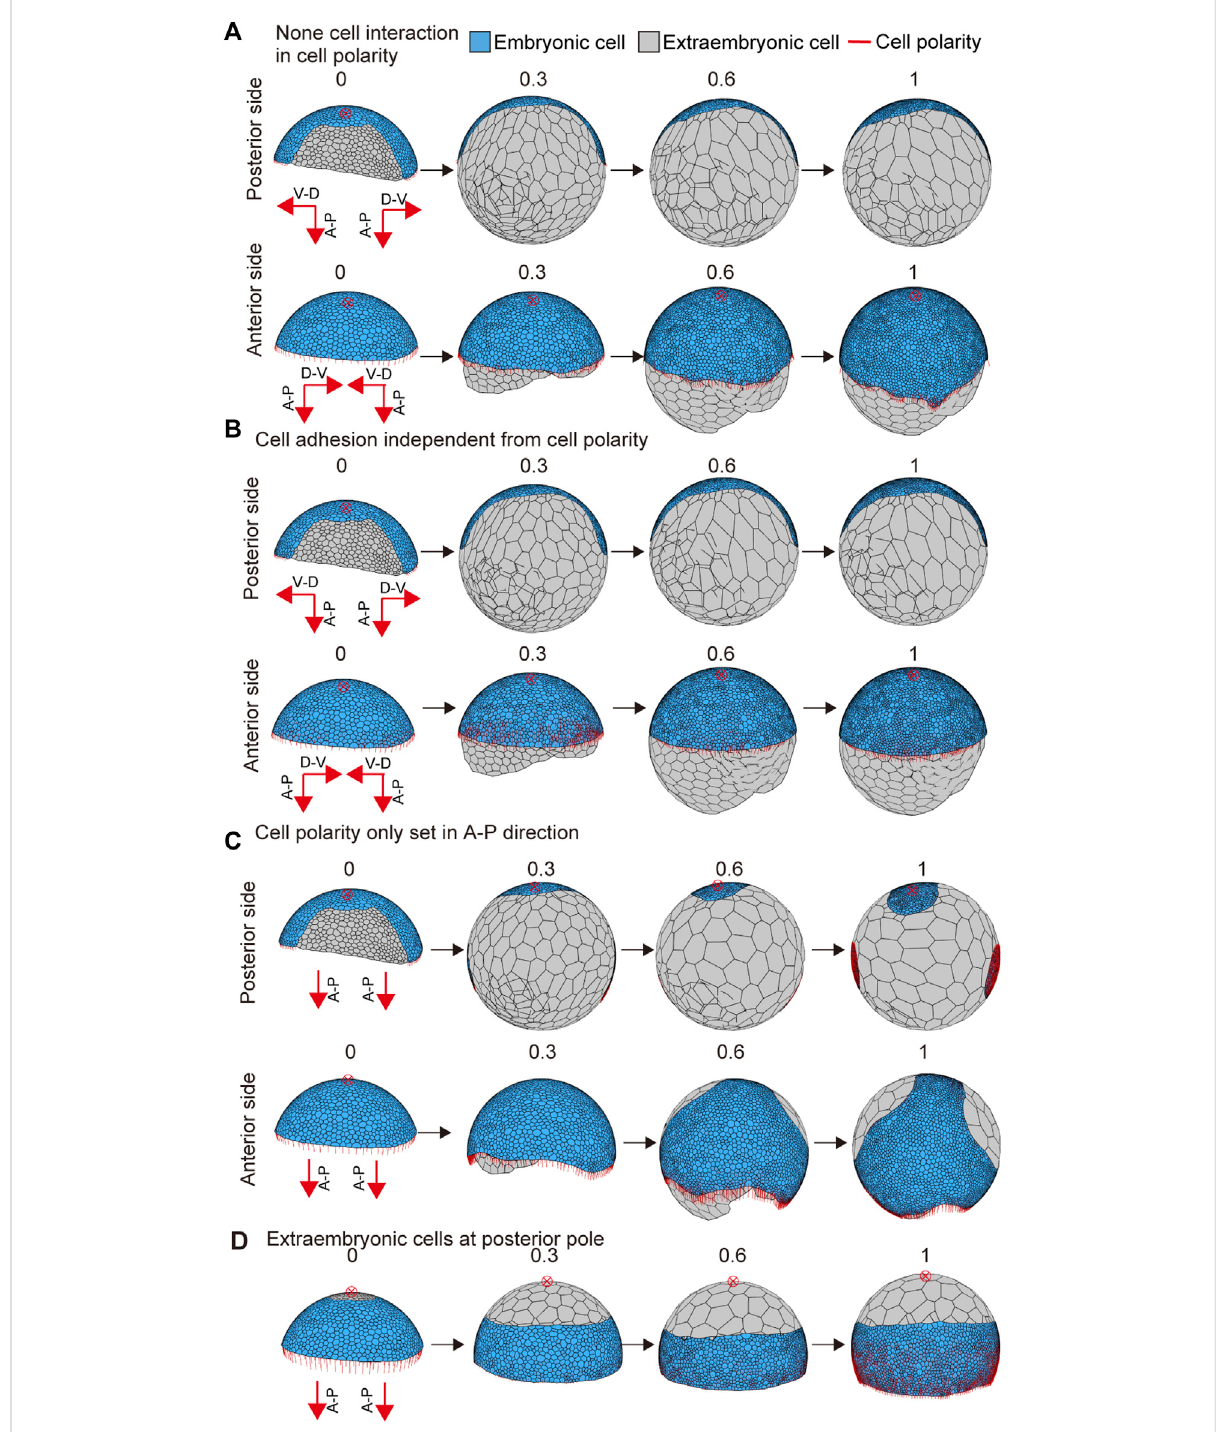
FIGURE 5 Embryo shape change as affected by parameter values or initial conditions. (A) Blocking the interaction between neighboring cells in cell polarity ( k fd = 0 in Eq. 6). The initial conditions for cell polarity are the same as shown in Figure 4B. (B) Interrupting the dependency between cell polarityandcelladhesion( G =0inEq.7).TheinitialconditionsforcellpolarityarethesameasshowninFigure4B. (C) Changing theinitialconditions for cell polarity shown in Figure 4B. The development time of embryo shaping when cell polarity was only set in the A-P axis direction. (D) Changing the initial conditions for cell differentiation shown in Figure 4B. The development time of embryo shaping when the extraembryonic cells were positioned around the posterior pole of the embryo (red cross with a circle). The red cross with a circle indicates the posterior pole position. Numbersoneachpanelrepresentthedevelopmentaltime(initialstate t =0toafterthedeformation t